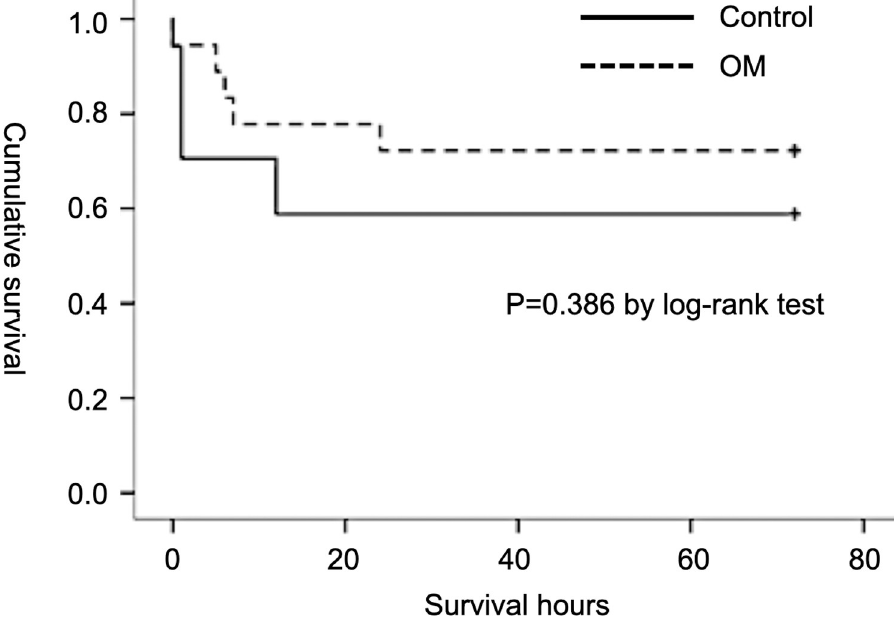
Fig 3. Kaplan-Meier survival curve of control and OM groups 72 h after cardiac arrest and resuscitation. (P = 0.386 by log-rank test).